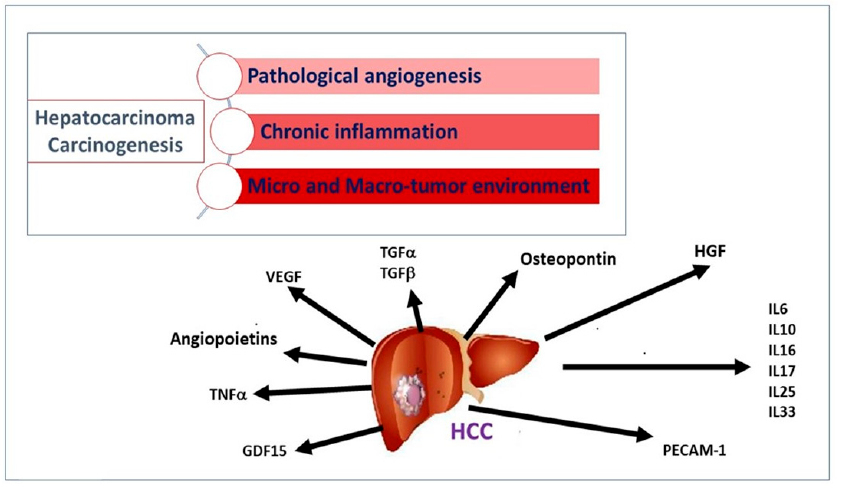
Figure 1. Major pathogenetic events and cytokine network involved in hepatocellular carcinogenesis. Following persistent liver damage, locally activated chronic inflammation favors the release of soluble factors sustaining the proliferation and survival of tumor cells. Angiogenic factors (angiopoietins, VEGF), growth factors for normal and transformed hepatocytes (HGF), adhesion molecules and cytokines for recruitment and activation of leukocytes (PECAM, IL-6), and stellate cells upregulates TGF in the liver and, consequently, regeneration, proliferation, and hepatocyte dysplasia, and, ultimately, the development of HCC.